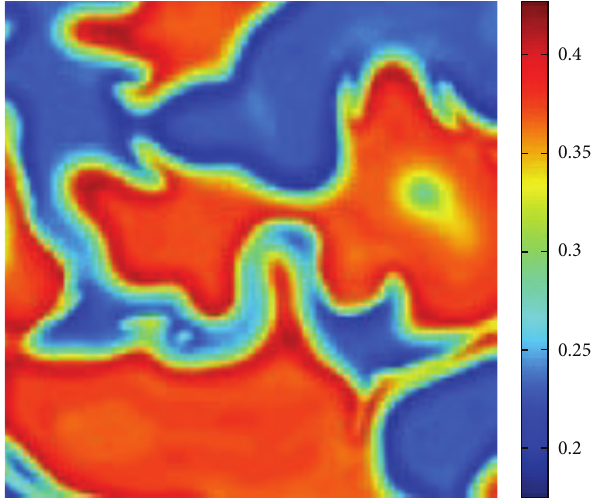
Figure3: Snapshotsofcontourpicturesofthevegetation at 𝑡 = 1000 with 𝜀 = 0.07 and 𝜏 = 6 . Other parameters’ values are the same as in Figure 1(b).